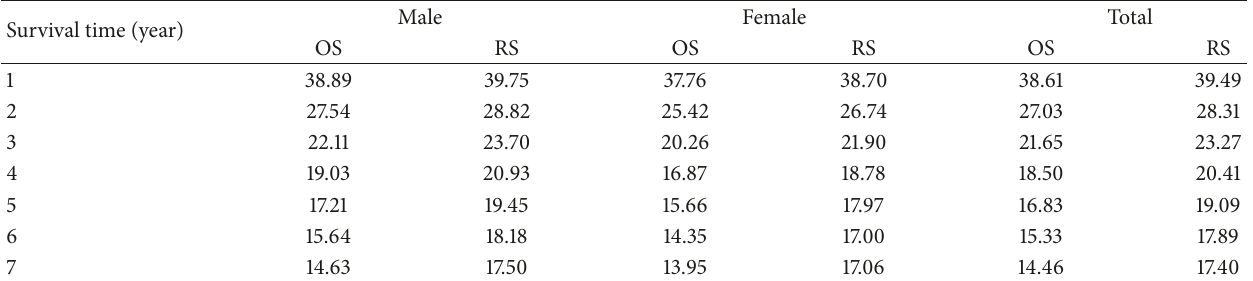
Table 2: Observed and relative survival rate of liver cancer in Zhejiang province from 2005 to 2010